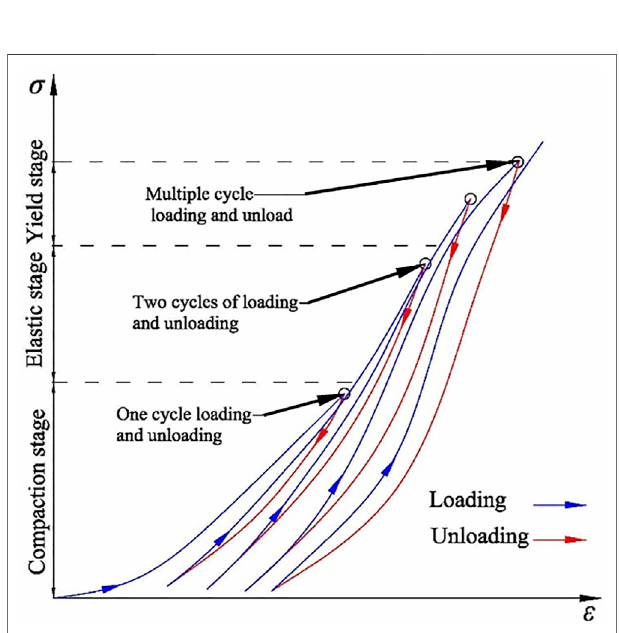
FIGURE 2 | Stress loading paths in preparation of coal samples with different degrees of CID.